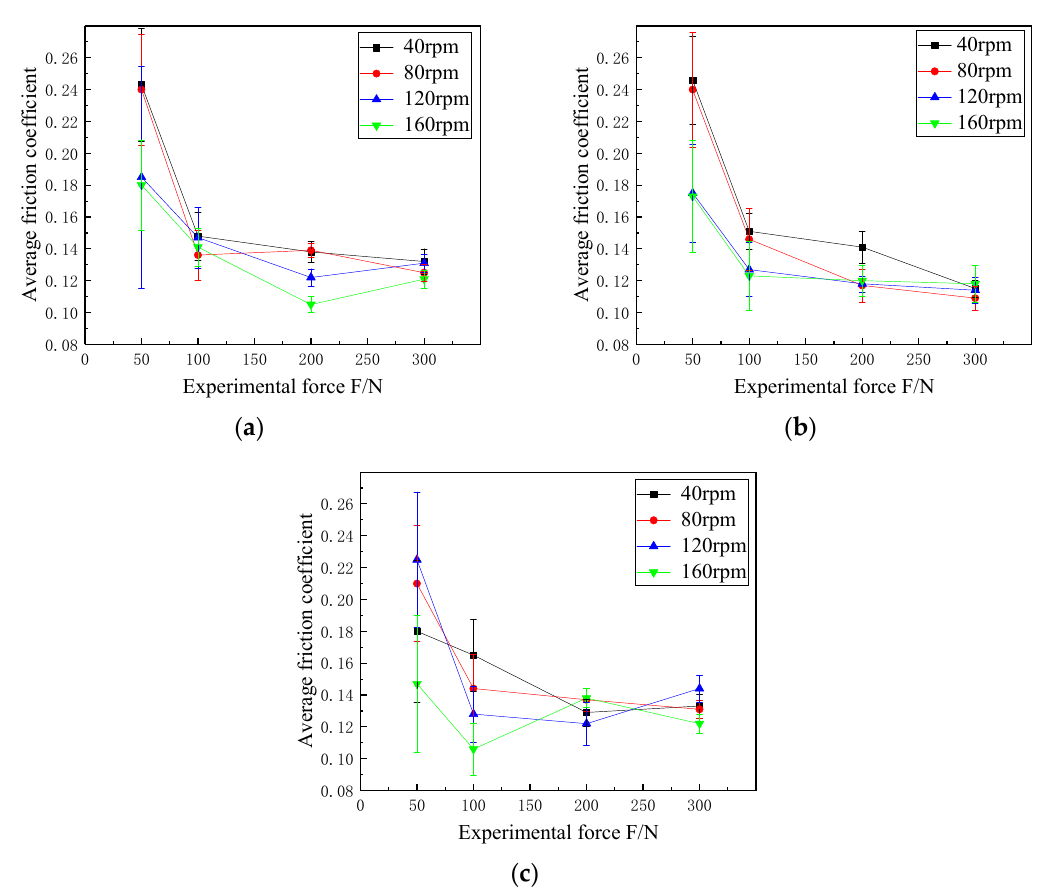
Figure 9. Friction coefficients of triangular textured surface with different area occupancy ratios: ( a ) area occupancy ratio of 7%; ( b ) area occupancy ratio of 10%; ( c ) area occupancy ratio of 13%.